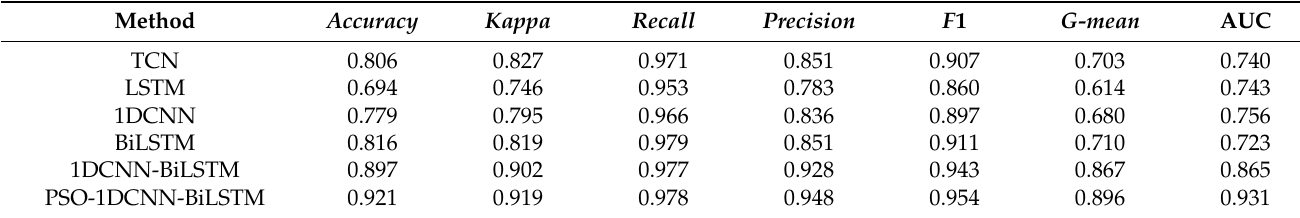
Figure 6. Model convergence performance during the training phase. Table 1. Results of Testing